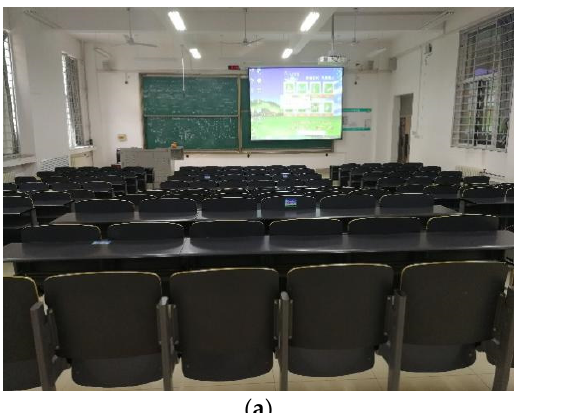
Figure 1. The monthly variation of temperature and relative humidity in Xi’an (2010–2019) [41].